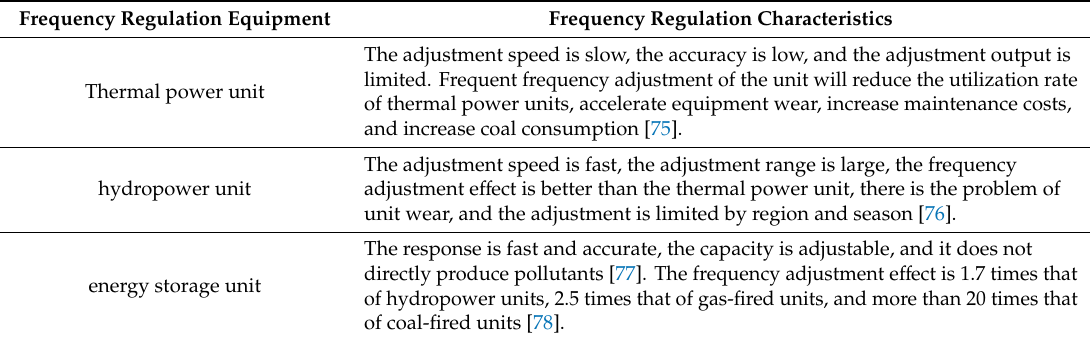
Table 4. Comparison of frequency regulation characteristics between battery energy storage system and conventional